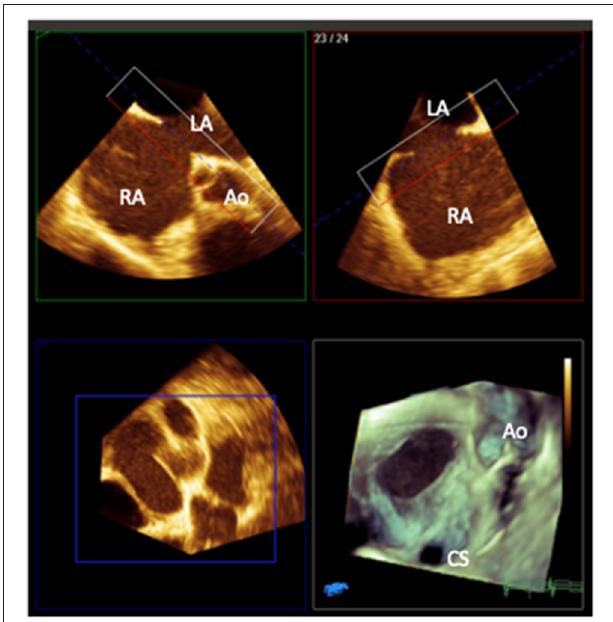
FIGURE 1 | 3D multiplanar reformat and rendered image (bottom right) of a transesophageal image of a secundum atrial septal defect with a deficient aortic rim as viewed from the right atrial aspect (Ao, aorta; CS, coronary sinus; RA, right atrium; LA, left atrium). Image courtesy of Alexandra Savis, Evelina London Children’s Hospital.